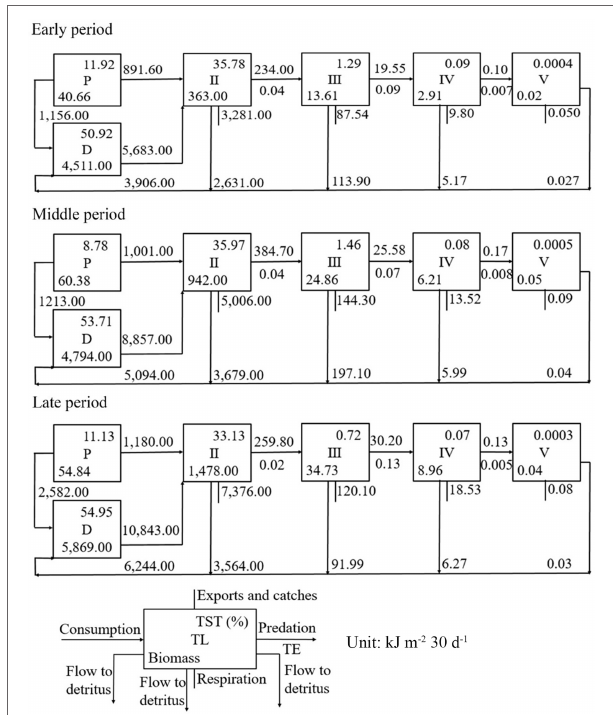
FIGURE 2 | Aggregation of flows and biomass (kJ m -2 30 d -1 ) of a Portunus trituberculatus polyculture ecosystem during the early, middle, and late periods, respectively (D, detritus; P, primary production; TL, trophic level; TE, transfer efficiency; TST, total system